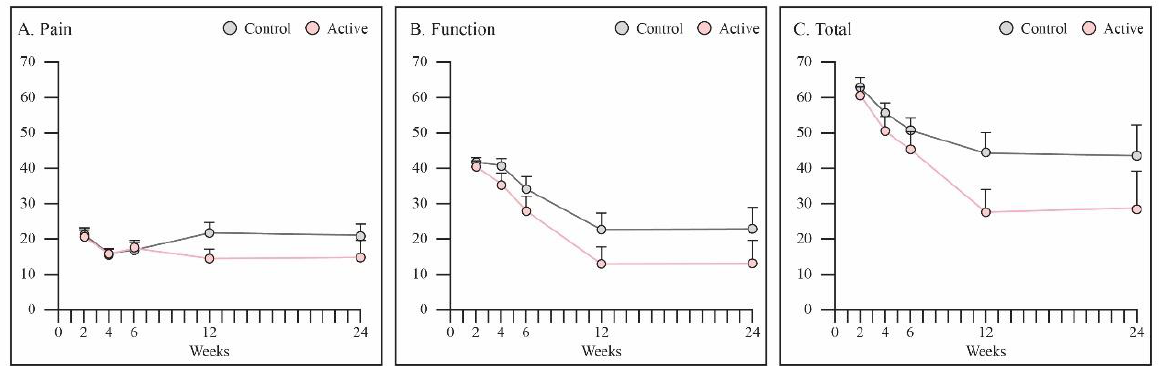
Figure 6. Assessment of functional outcome using PRWE. ( A ) Pain sub-score was better in the PEMF group at week 12 ( p = 0.06). ( B ) No differences were found in the function sub-score between groups. ( C ) Total PRWE score was better in PEMF treated patients at 12 weeks, however not statistically significant ( p = 0.07). Graphs are reported as mean ± SE. Student’s t -test.